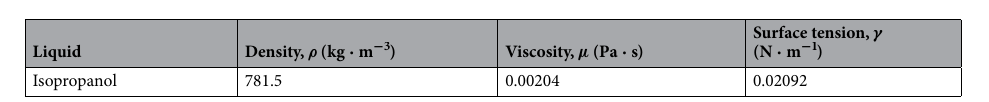
Table 1. Physical properties of the test fluid isopropanol at 25 °C.